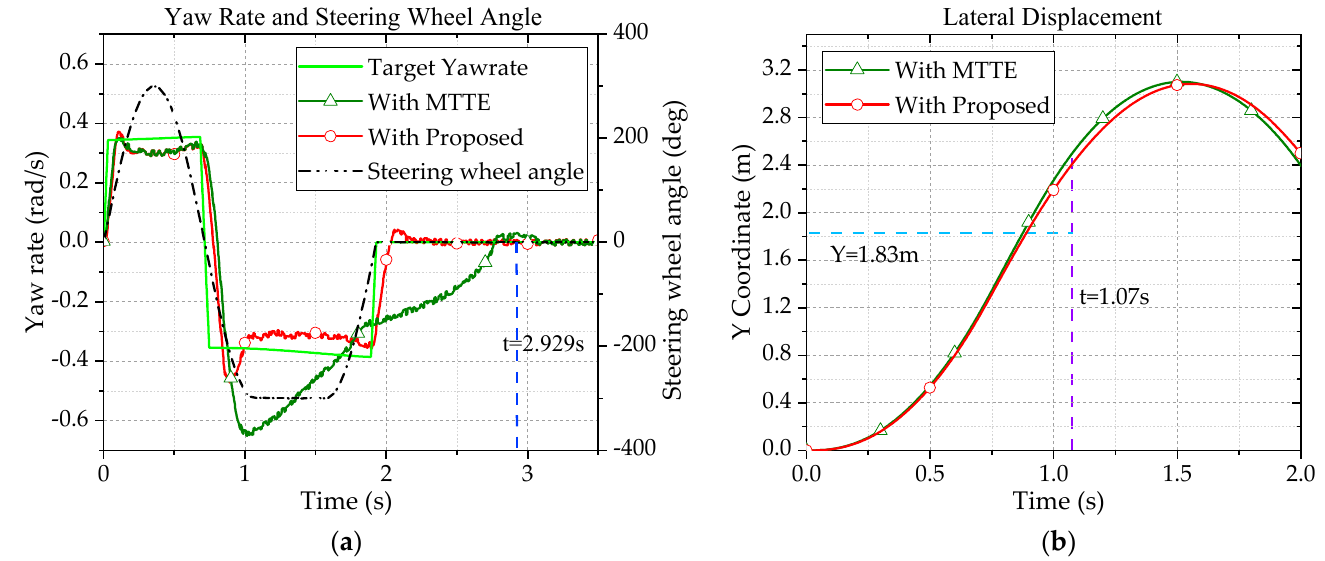
Figure 8. Sine with dwell simulation results on a high-adhesion road: ( a ) the yaw rate and steering wheel angle; ( b ) lateral displacement.